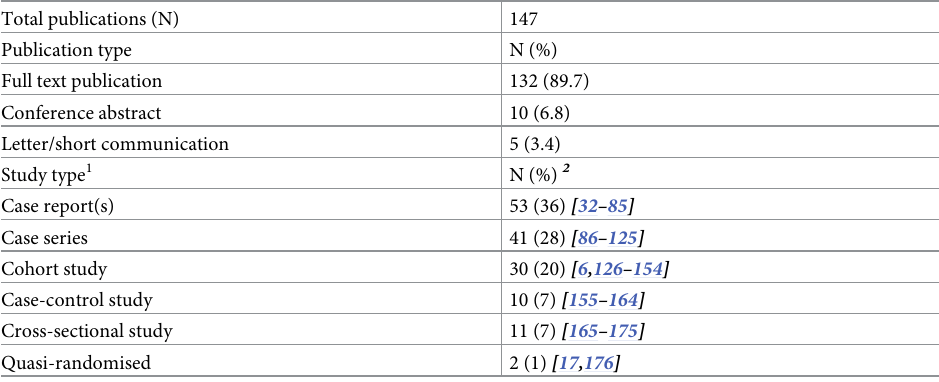
Table 1. Number of studies included by study